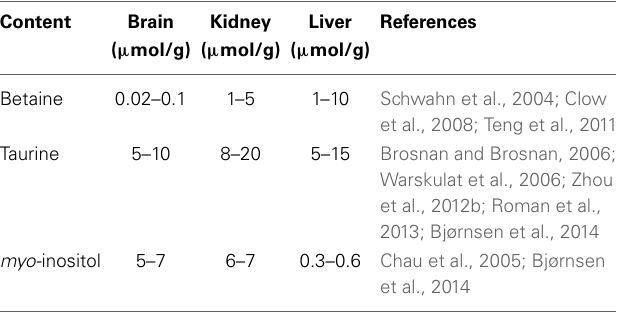
Table 1 | Summary of osmolyte concentrations in mouse